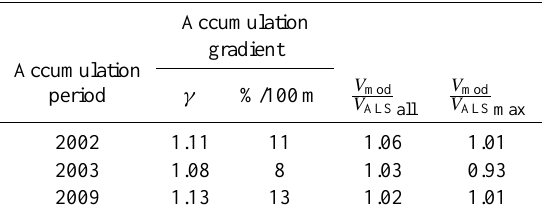
Fig. 6. Graphs of the elevation distribution of SWE in terms of specific accumulation (left column) and volume (right column) ob- tained from ALS data (red line), by modeling with constant gradient (blue line) and precipitation measurements (green triangle). Values are shown for the state at the end of the accumulation seasons. The black dotted curves show the upper and lower limit of error range. Table 3. Accumulation gradients and ratios between modeled vol- ume and volume derived from ALS measurements for catchment sum (index all) and elevation band of largest area (index max).